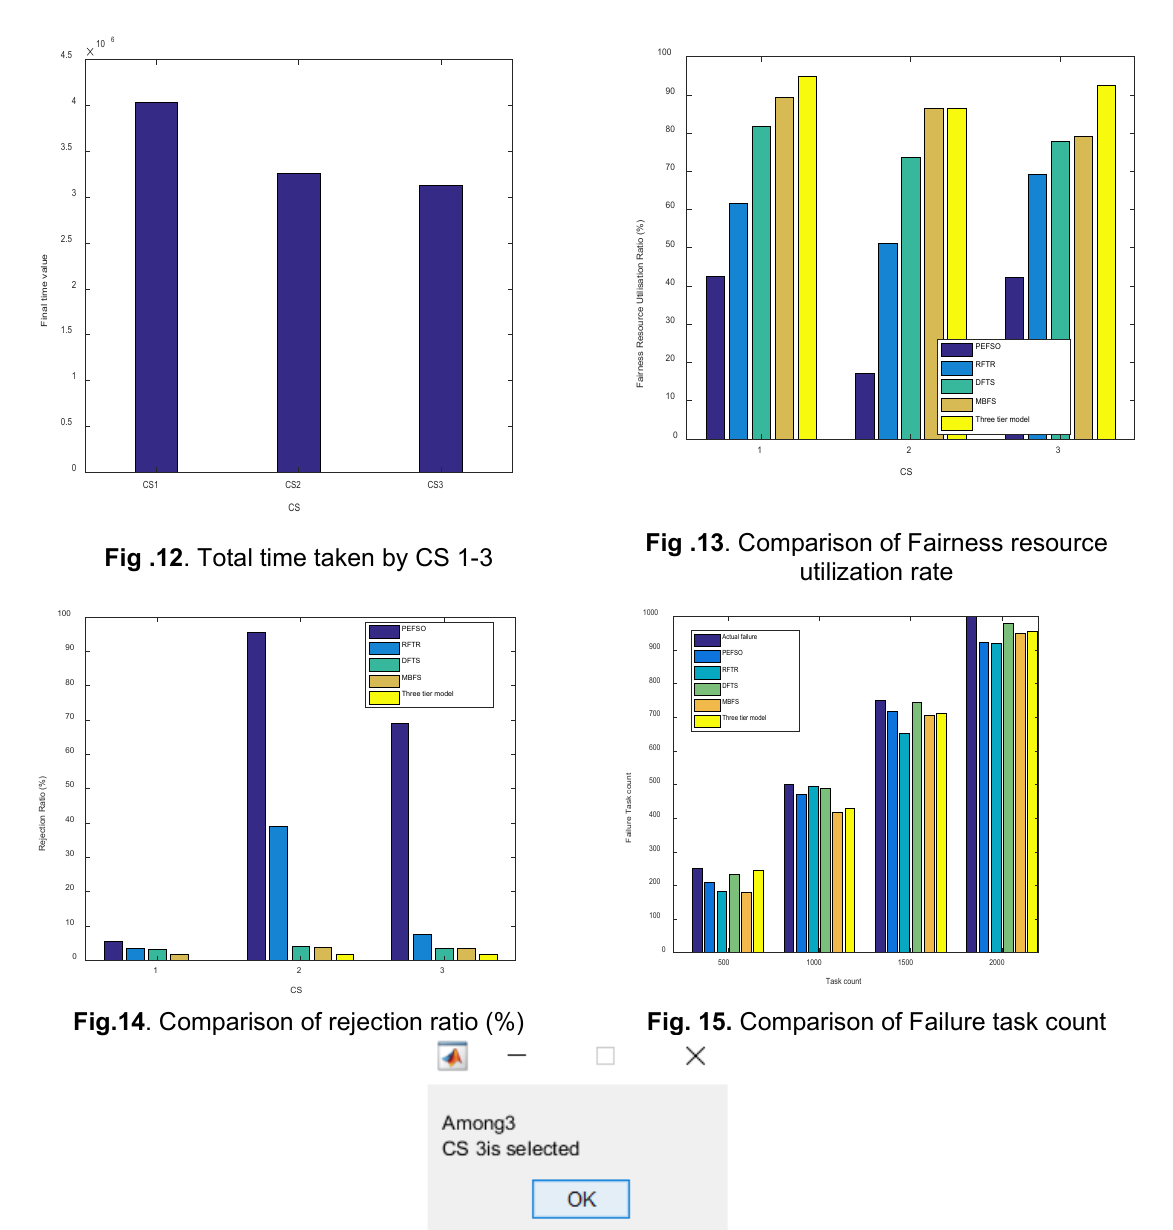
Fig .16. Selection of cloud service